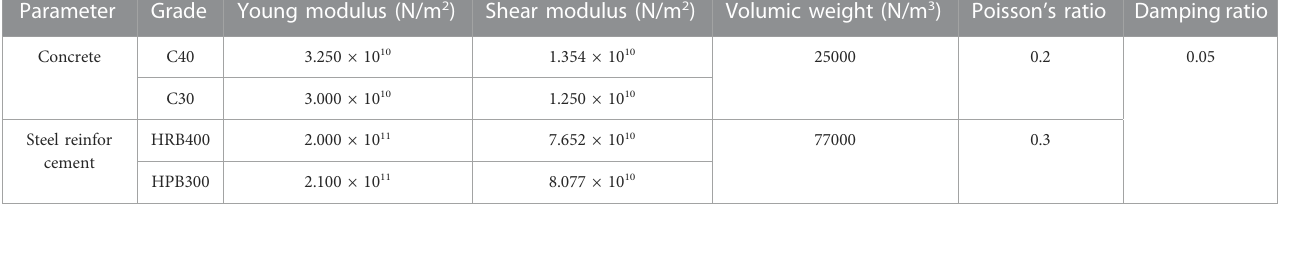
TABLE 5 Design parameters of isolated